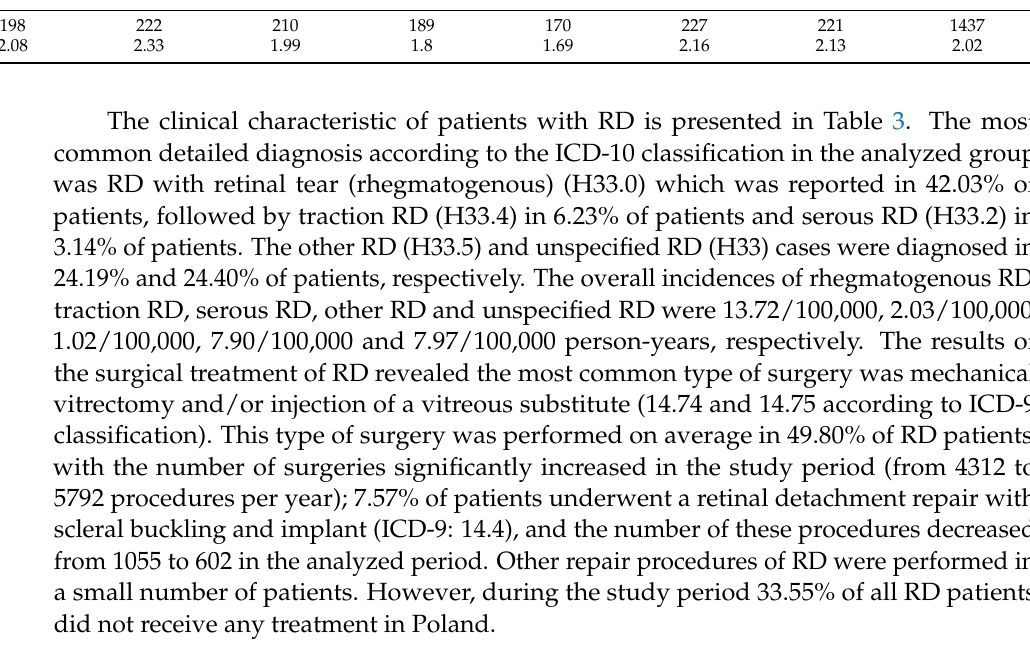
Table 3. The clinical characteristics of patients with RD in Poland during